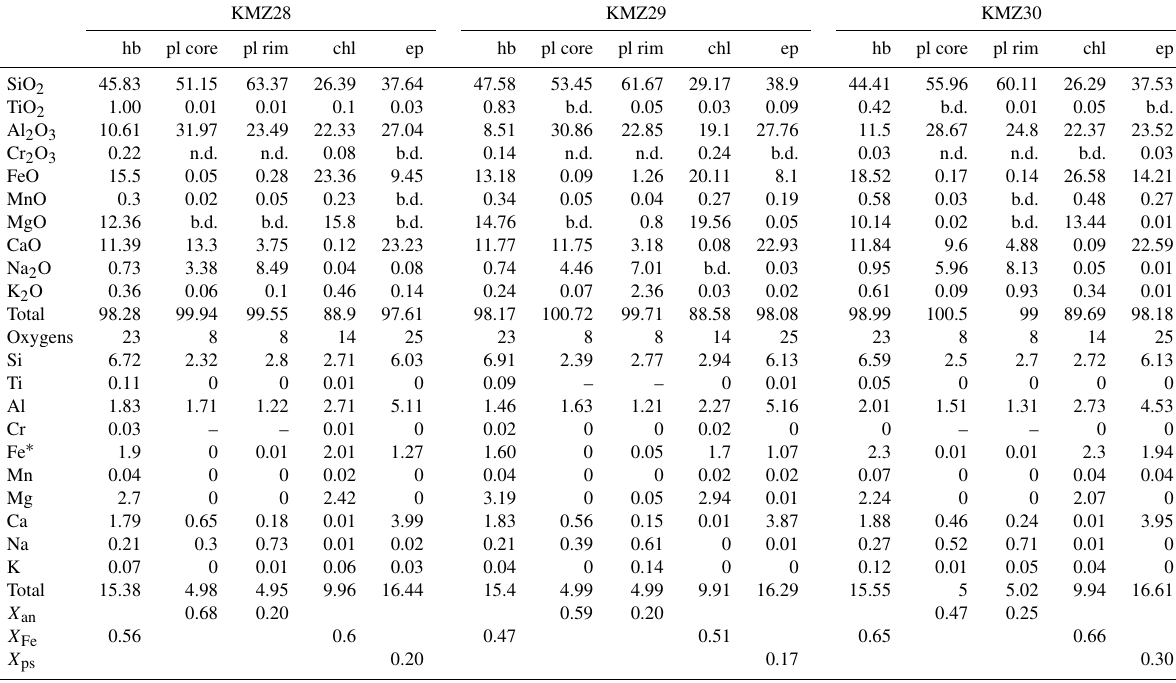
Table 1. Representative mineral compositions. b.d.: below detection limit; n.d.: not determined. KMZ28